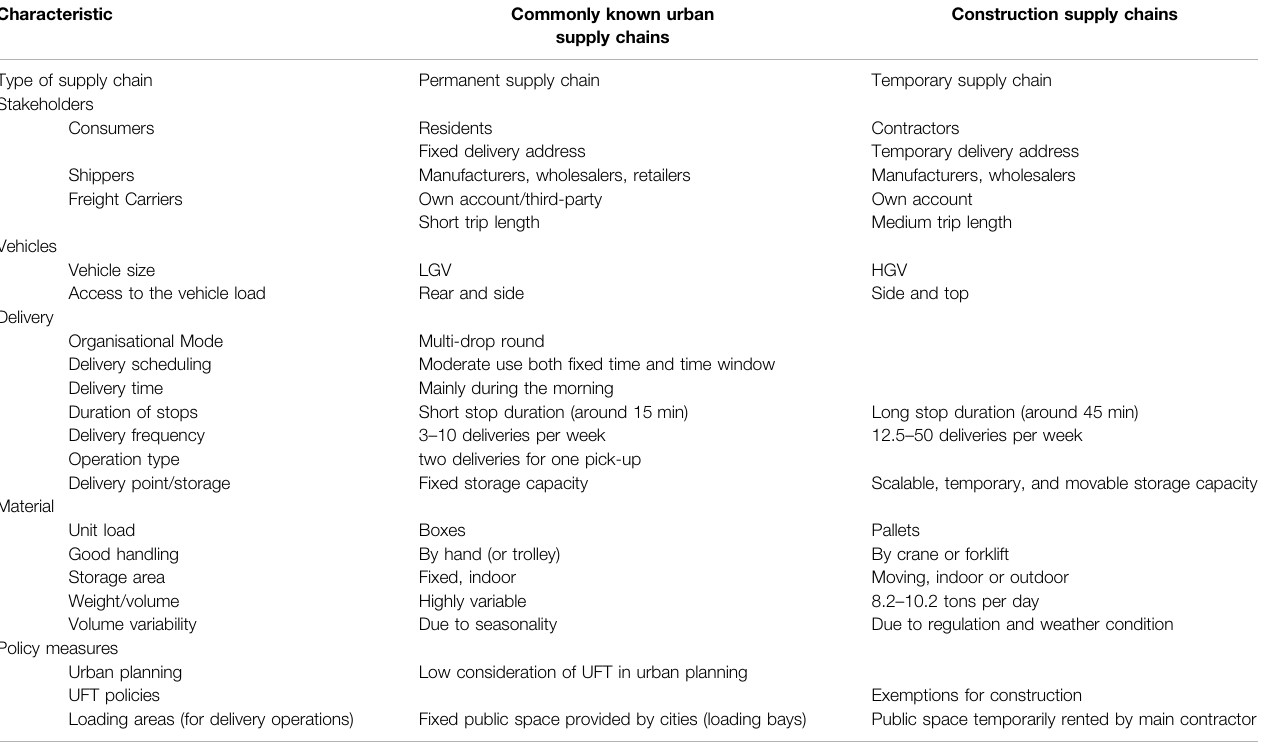
TABLE 2 | Comparison of Common Urban Supply Chains and Construction Supply Chains speci fi c to transportation/material delivery (Guerlain et al., 2019b).